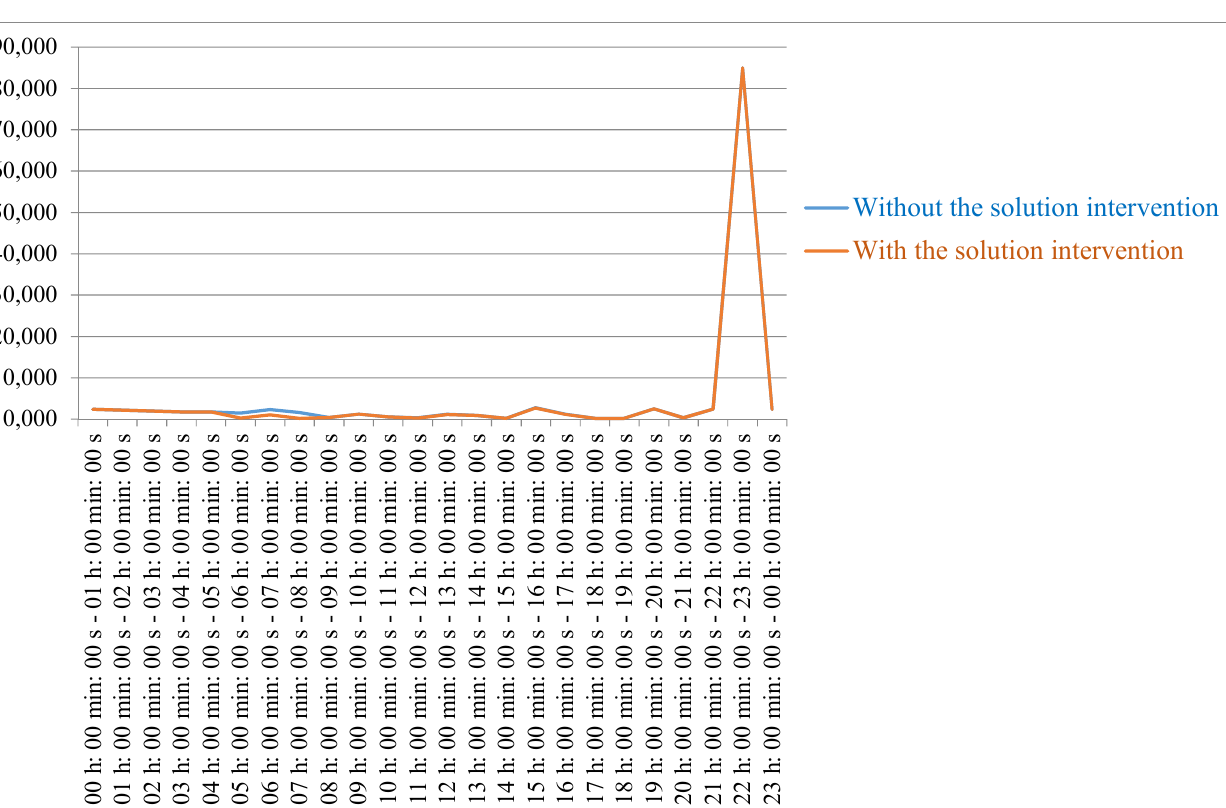
Figure 10. Energy consumption with and without the IRRHEM intervention.